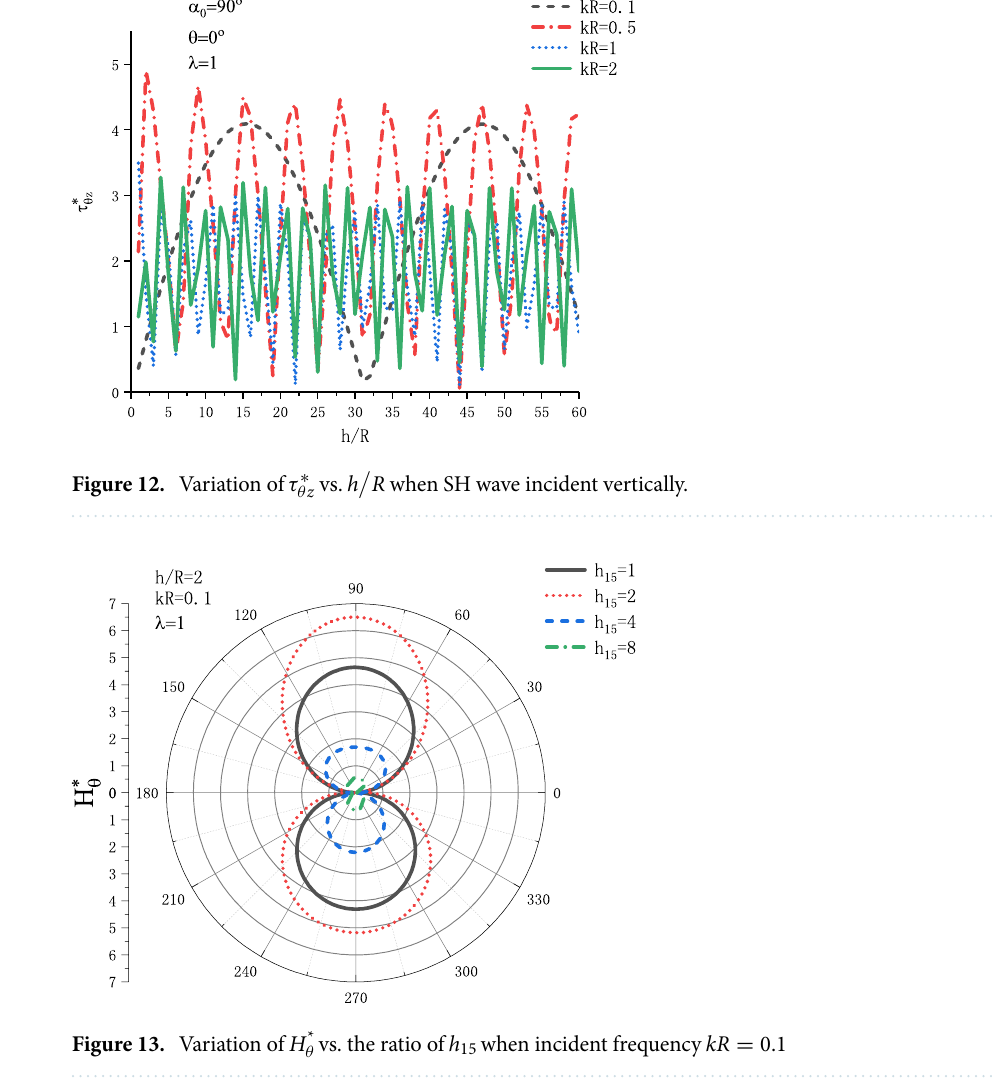
Figure 13. Variation of H